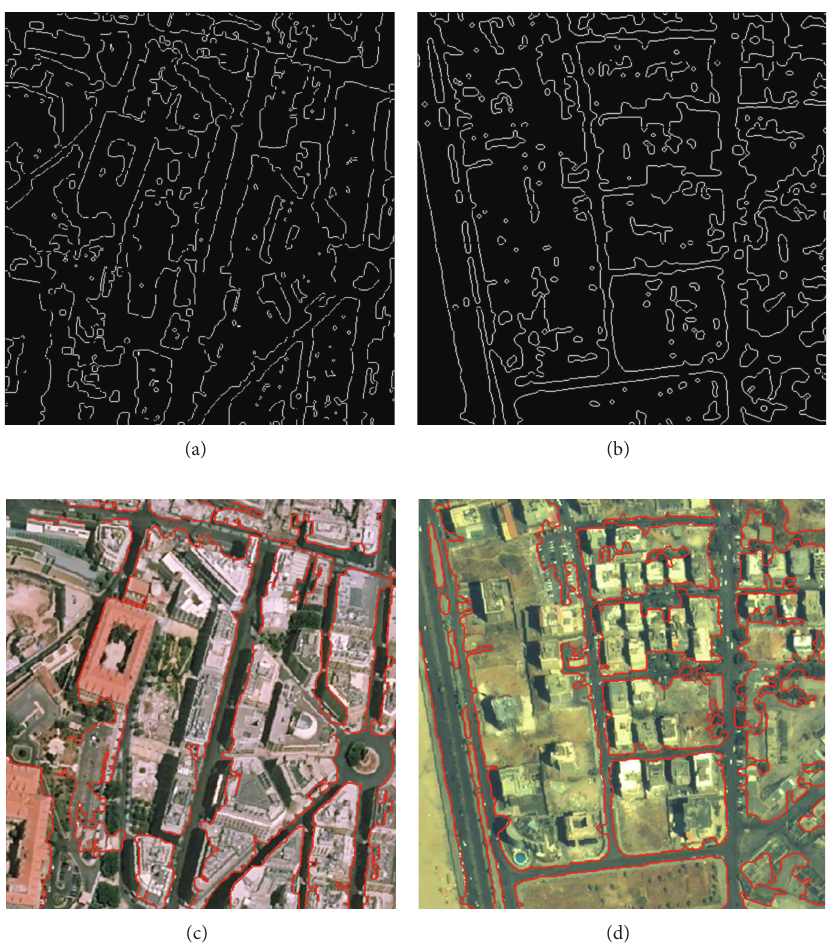
Figure 5: Final results of ((a) and (b)) applying Canny-Deriche and ((c) and (d)) conversion and